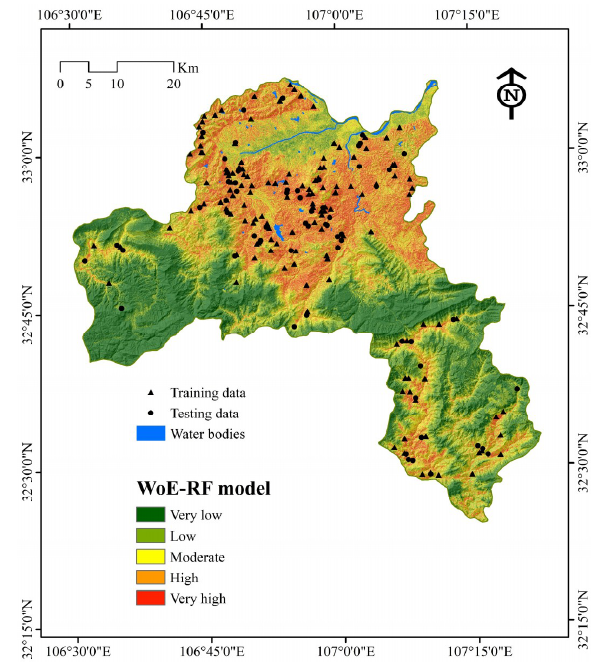
Figure 6. Mean decrease accuracy and mean decrease Gini.